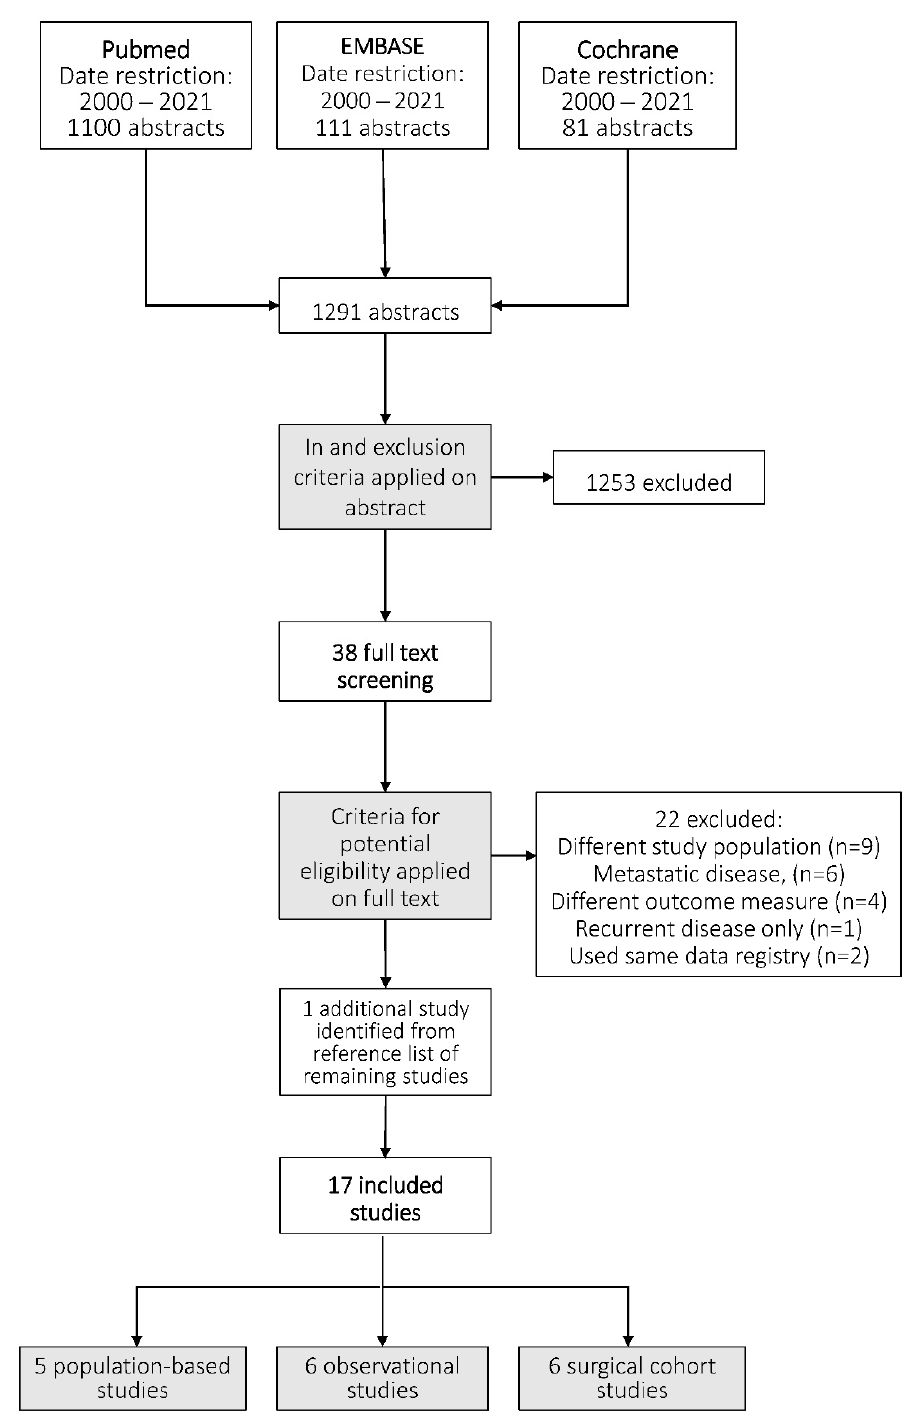
Figure 1. Literature search and study selection. Details of the literature search and study selection are presented in the Appendix A and Appendix B, respectively.